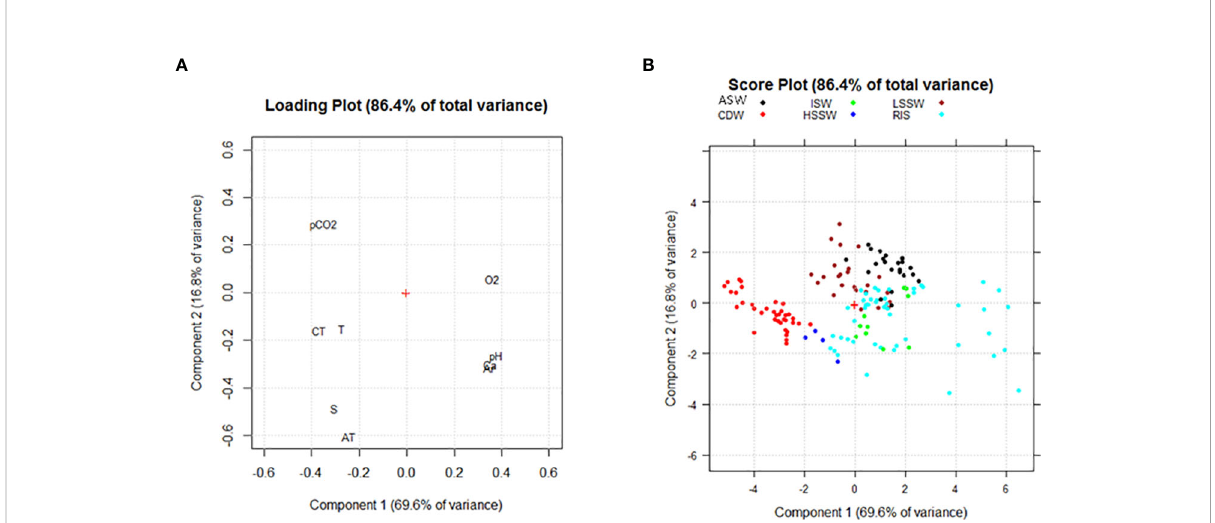
FIGURE 4 (A) Loading plot and (B) Score plot obtained from the PCA for samples collected at depths deeper than 100 m. The following abridgements were used for the variables in the loading plot: dissolved oxygen (O 2 ), total inorganic carbon (C T ), total alkalinity (A T ), partial pressure of CO 2 (pCO 2 ), saturation grade of calcite and aragonite (Ca and Ar), temperature (T) and salinity (S). The following colors were used to identify water masses: black = Amundsen Sea Water (ASW); brown = Low Salinity Shelf Water (LSSW); red = Circumpolar Deep Water (CDW); green = Ice Shelf Water (ISW); blue = High Salinity Shelf Water (HSSW); cyan = Shelf Waters sampled along the RIS that belong to neither HSSW nor ISW